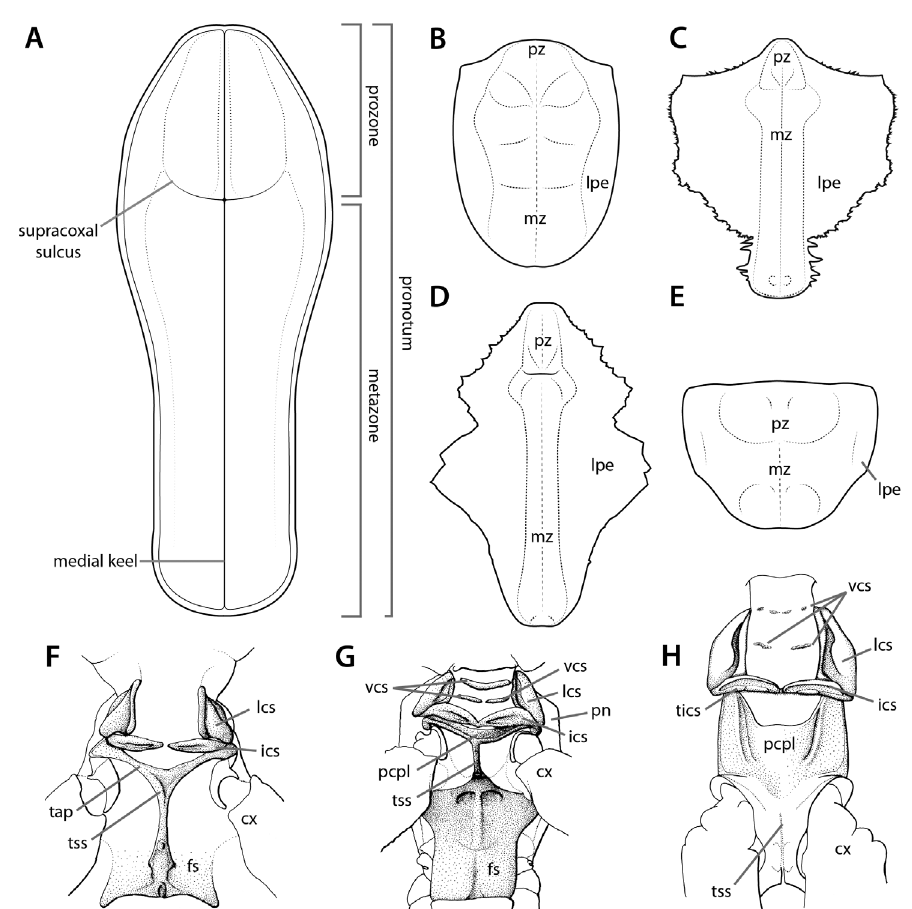
Figure 8. Annotated illustrations of thoracic structures. Pronotum in dorsal view A Sphodromantis sp. ♂ (illustration by Josh Maxwell) B Theopompella congica Rehn, 1949 ♀ C Idolomantis diabolica (Saus- sure, 1869) ♀ D Deroplatys indica Roy, 2007 ♂ E Amorphoscelis pulchella ♀ . Prothorax in ventral view F Mantoida maya ♂ G Humbertiella Saussure, 1869 ♀ H Phyllocrania paradoxa ♂ . Figures F – H reproduced and adapted from Wieland (2013). Structures not to scale. Abbreviations: cx = coxa; fs = furcasternite; ics = intercervical sclerite; lcs = lateral cervical sclerite; lpe = lateral pronotal expansion; mz = metazone; pcpl = postcervical plate; pn = pronotum; pz = prozone; tap = transverse anterior part of T-shaped sclerite; tics = torus intercervicalis; tss = T-shaped sclerite; vcs = ventral cervical